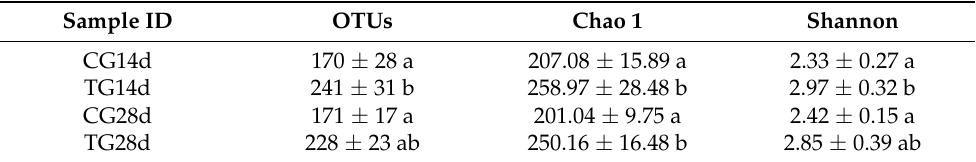
Table 3. OTUs classification information and alpha diversity index of microbial community in the intestines of crayfish.